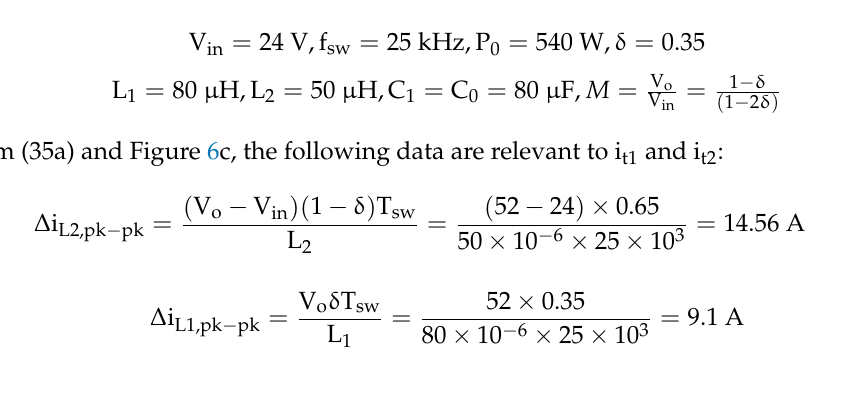
Figure 17. Converter 3-3.1terminal 3 and capacitor current waveforms .